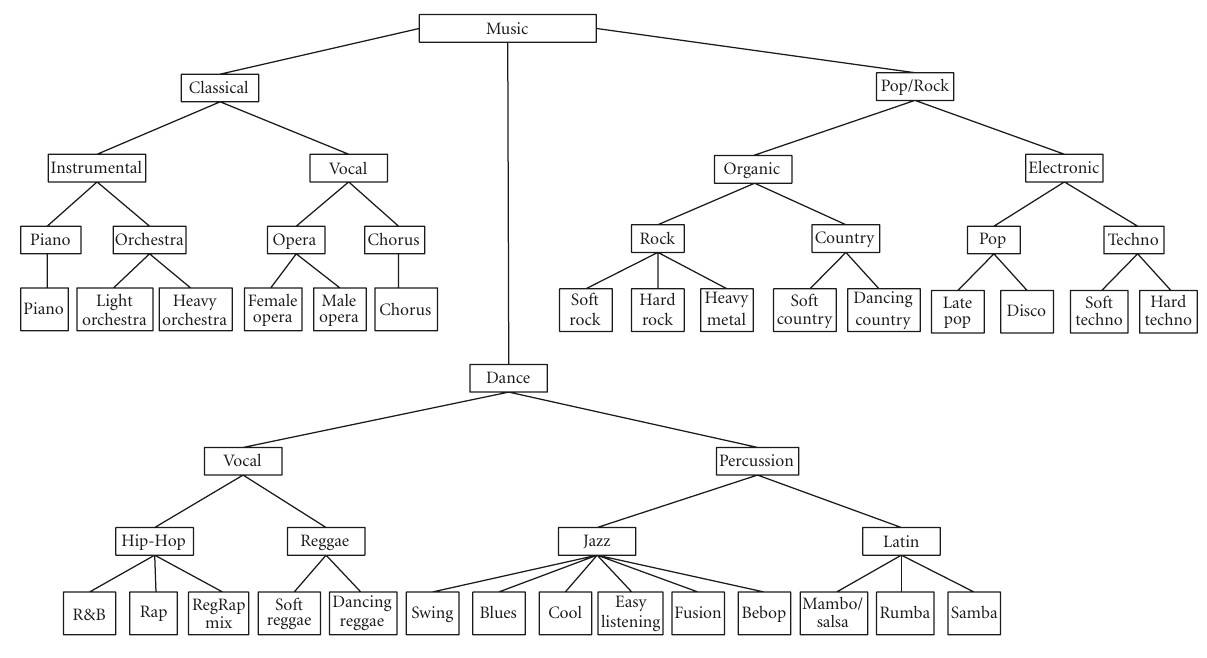
Figure 1: Musical genre